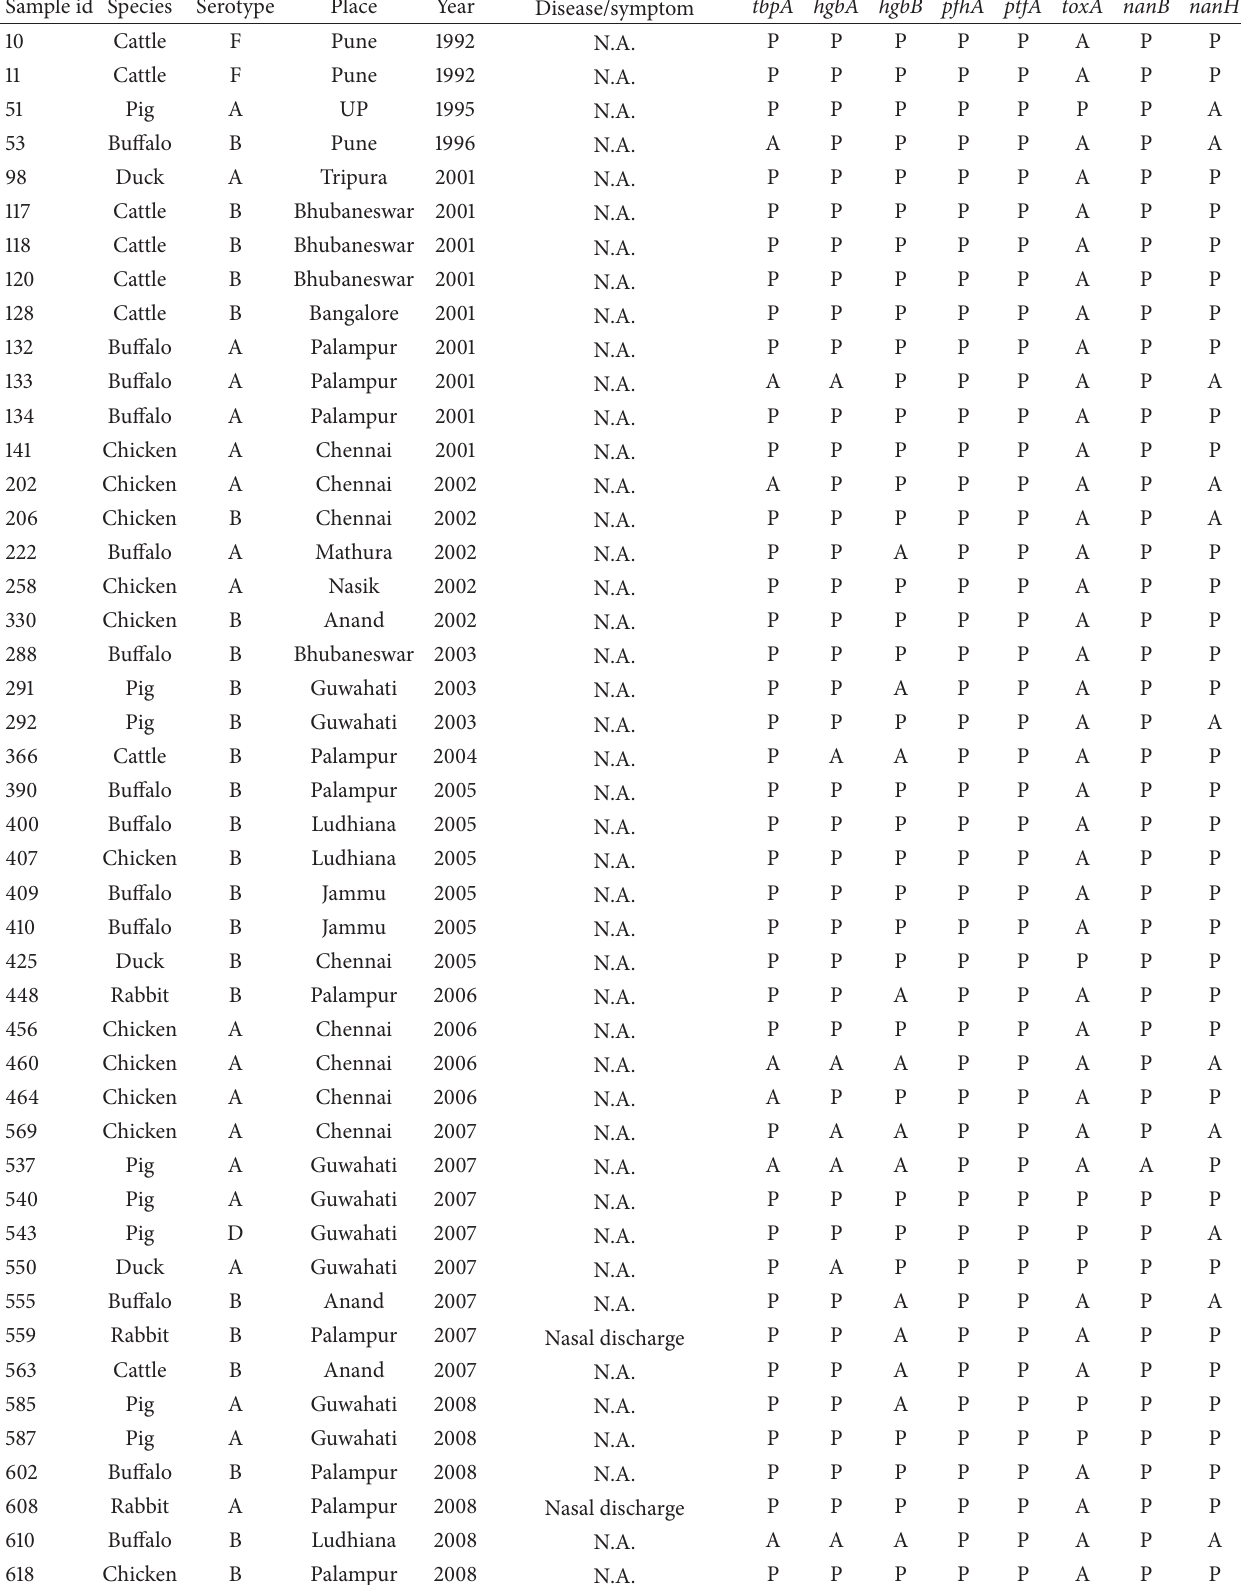
Table 1: Details of the isolates (host origin, serotype detected, place of isolation, year of isolation, symptom, presence/absence of individual virulence